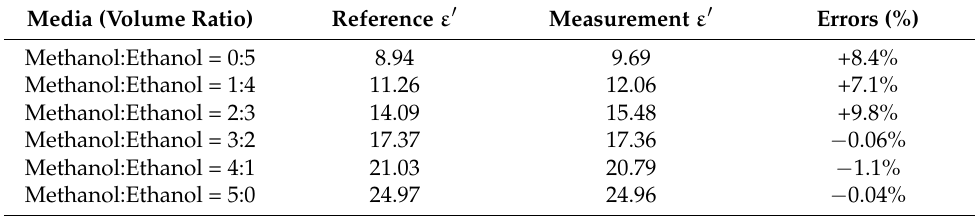
Table 2. Real part of the permittivity of solutions.